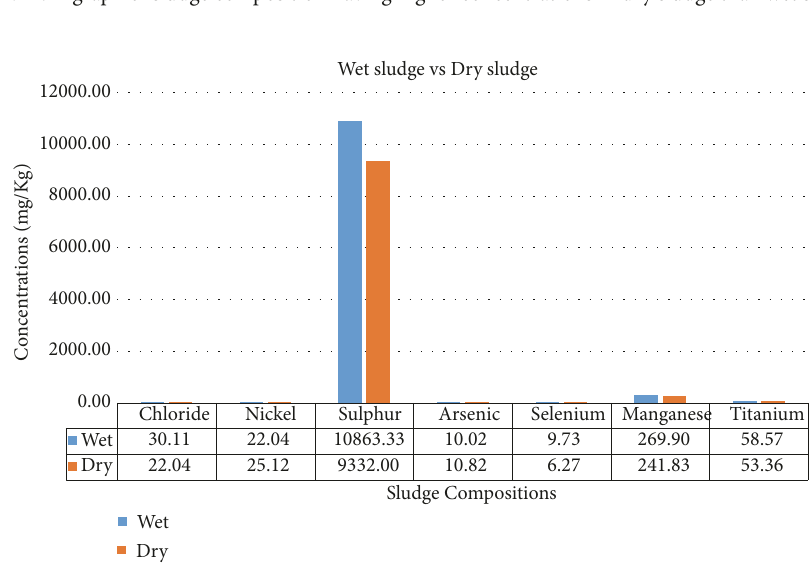
from dewatering the raw sludge without having gone through any biological